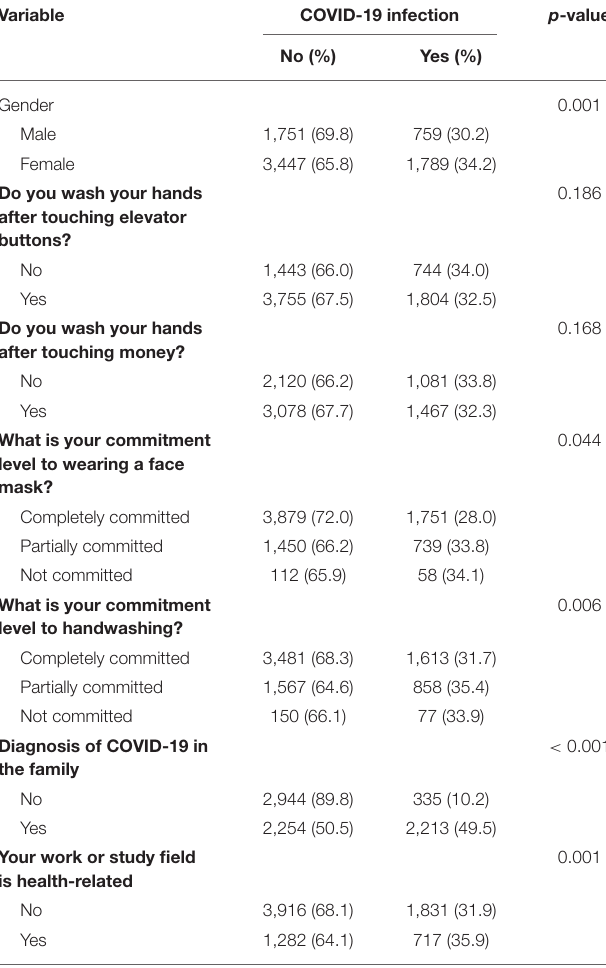
TABLE 3 | Cross-tabulation of factors associated with contracting COVID-19 infection. Variable